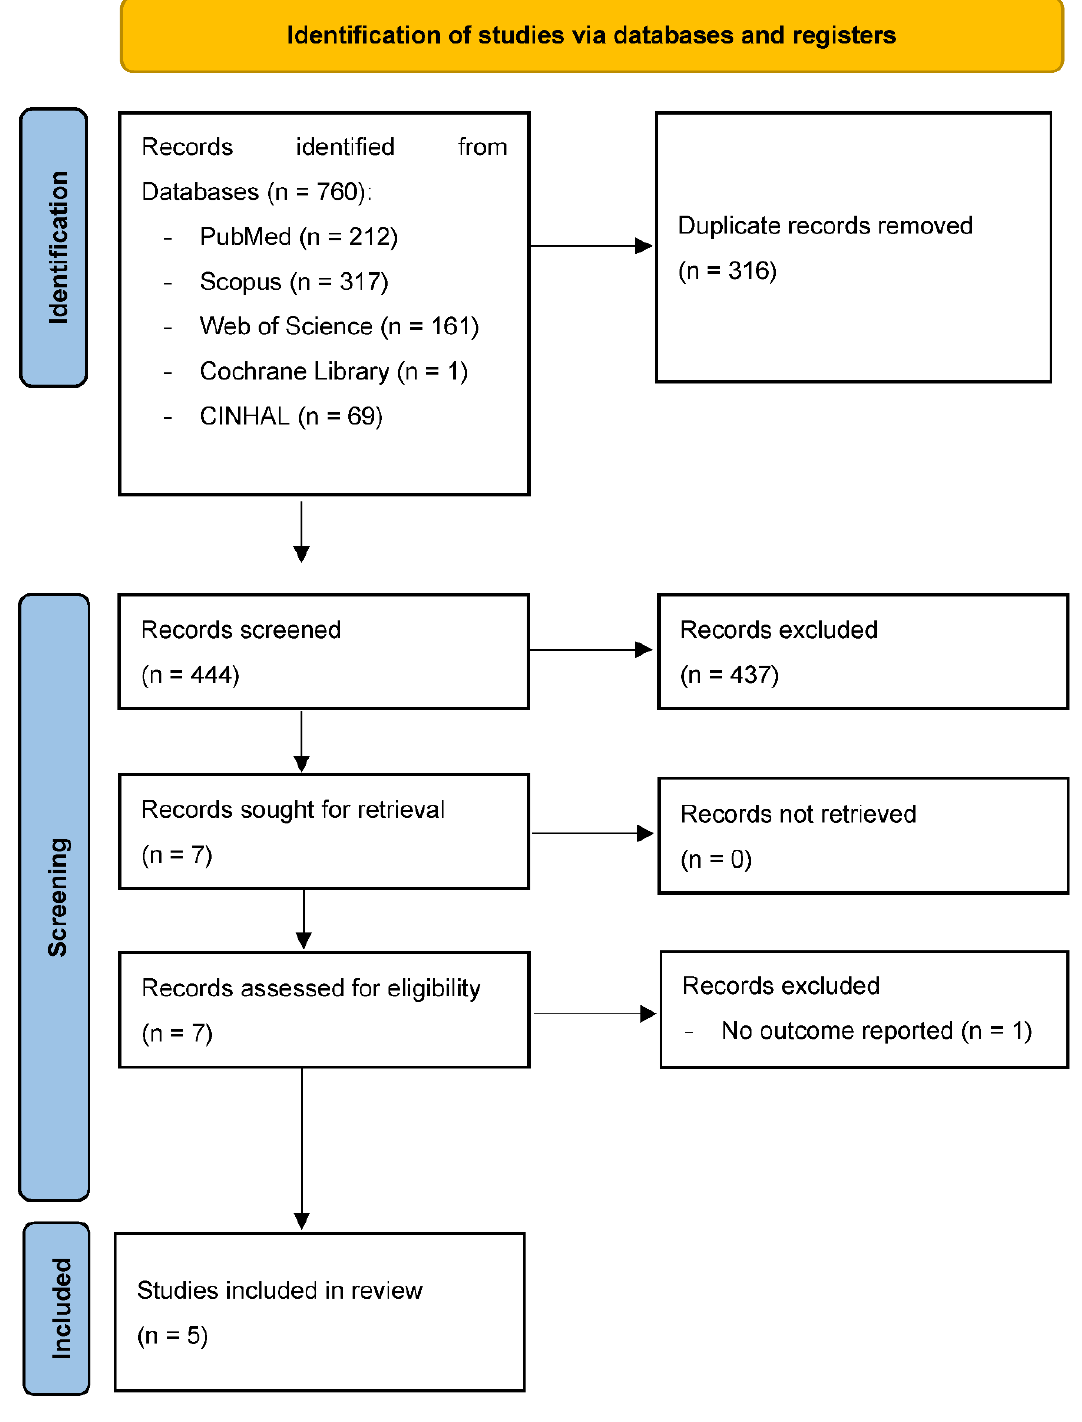
Figure 1. Selection of studies for the systematic review based on Preferred Reporting Items for Systematic Reviews and Meta-Analysis flow diagram (PRISMA 2020).